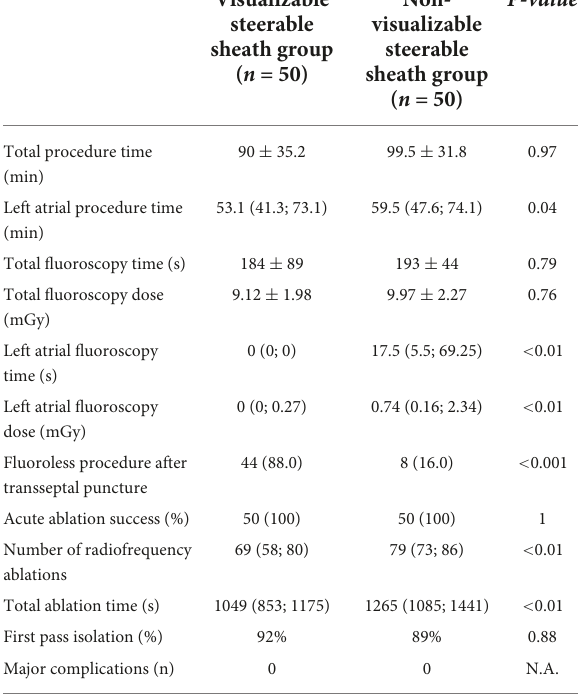
TABLE 2 Procedural parameters in the study